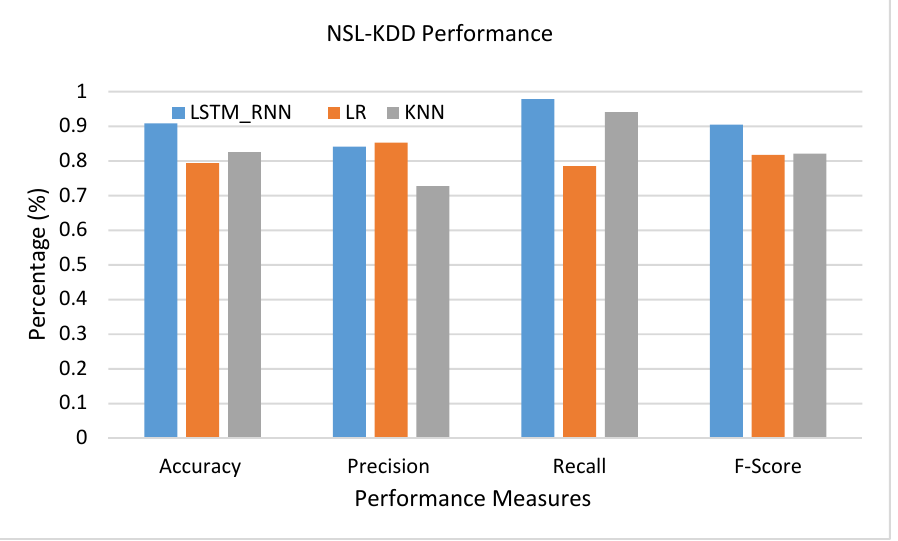
Figure 18. NSL-KDD Binary classification performance comparison.